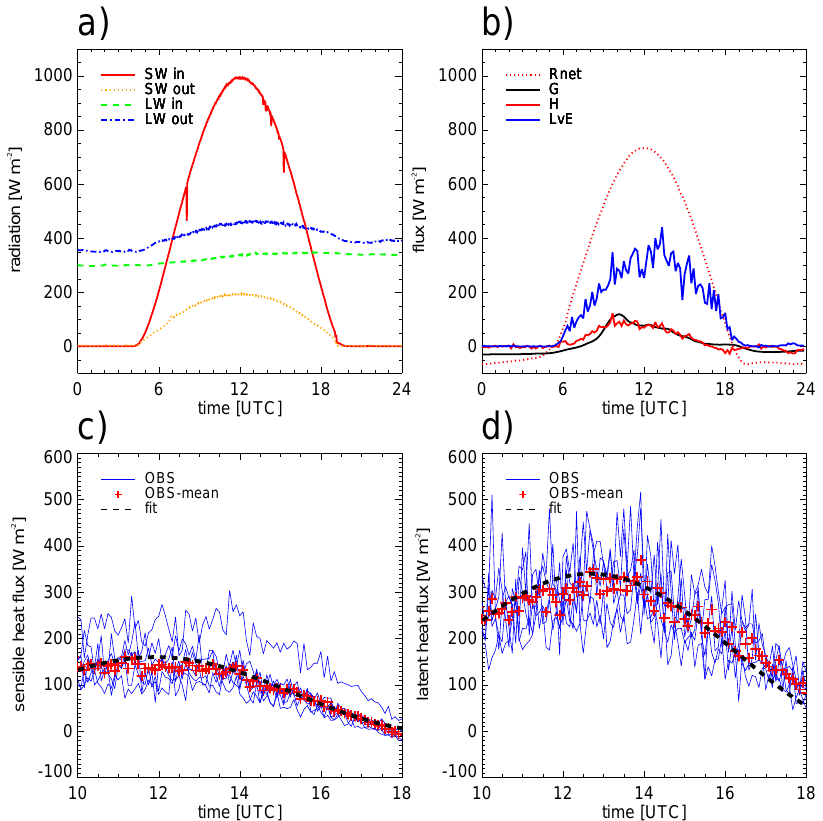
Figure 5. Temporal evolution of (a) the four components of the radiation budget, (b) the components of the surface energy budget, (c) sensible heat flux and (d) latent heat flux taken on 25 June 2011. The radiation and surface energy budget were measured at site 2, characterized by a footprint influenced by cropland and grass fields. The sensible (c) and latent heat (d) fluxes are from the seven stations shown in Fig. 4. The black dashed line is a fitted curve of the mean of the seven measurements (red crosses) and is used as the surface forcing (sensible and latent heat fluxes) in the numerical